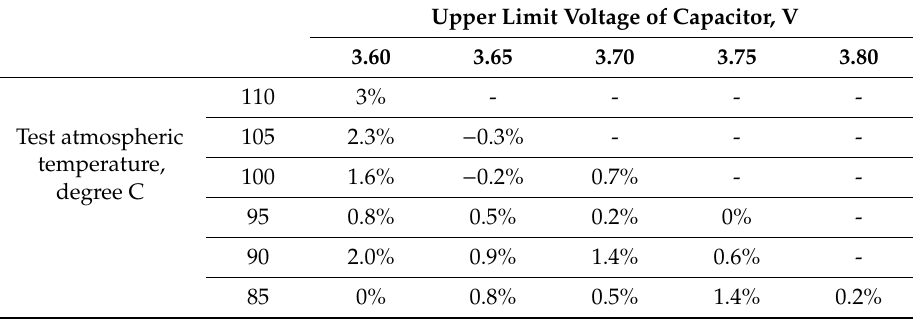
Table 3. Capacitance reduction behavior.